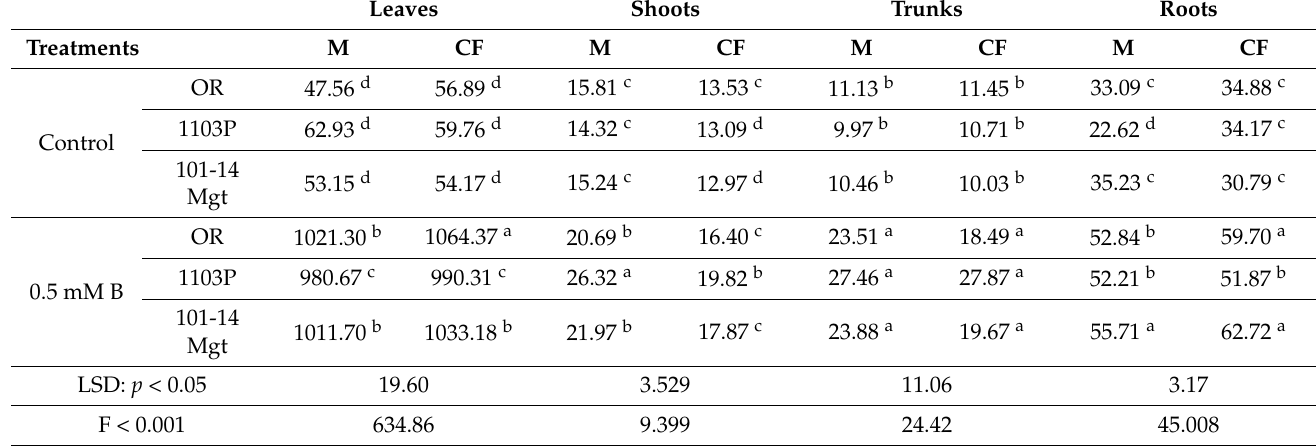
Table 2. The effect of boron toxicity on leaf, shoot, trunk, and root on B concentrations (mg kg − 1 d.w.) of own-rooted or grafted onto 1103P and 101-14 Mgt rootstocks of Merlot and Cabernet Franc vine cultivars. Trunks